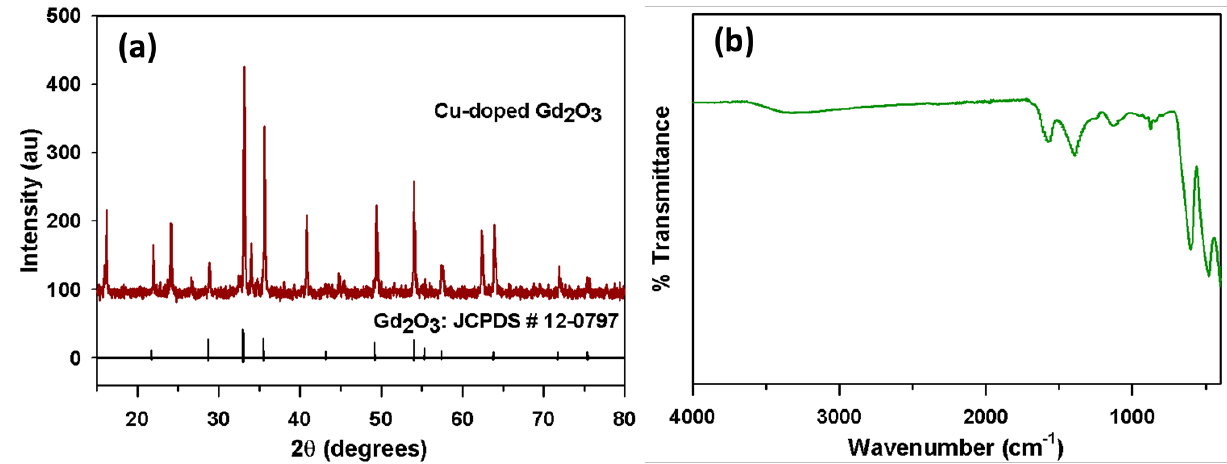
Figure 1. Structural and Optical characterization. ( a ) XRD spectrum and ( b ) FTIR spectrum of CGO nanofiber.